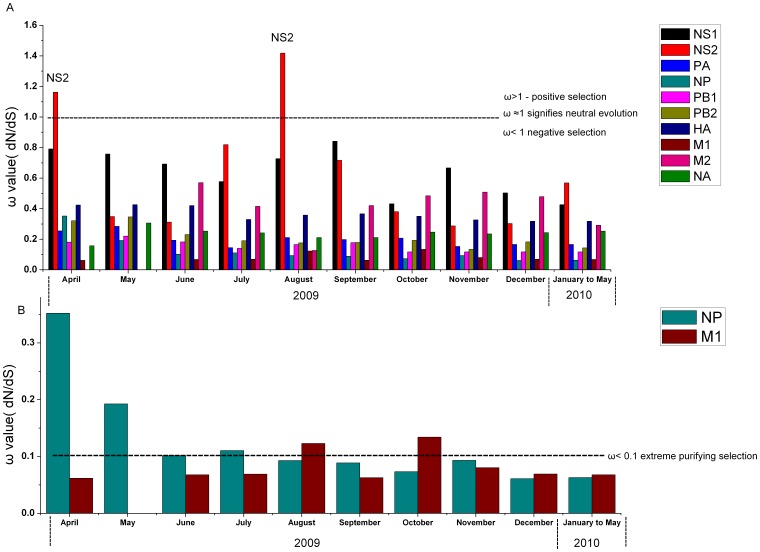
Selection pressure.Selection pressures on the whole sequence (ω) are calculated for the entire coding regions of the NS1, NS2, PA, NP, PB1, PB2, NA, HA, M1, and M2 genes of the novel swine-origin influenza virus A (H1N1) from April 2009 to May 2010. The number of gene sequences used in this study is shown in Table S1. The ratio ω = dN/dS has become a standard measure of selective pressure; ω≈1 signifies neutral evolution, ω<1 indicates negative selection, ω>1 indicates positive selection, and ω≤0.1 indicates extreme purifying selection. These results indicate that the NS2 gene was under positive selection in April and August 2009 but was under negative selection from May to July 2009 and from September 2009 to May 2010. The remaining eight genes were under negative selection from April 2009 to May 2010.